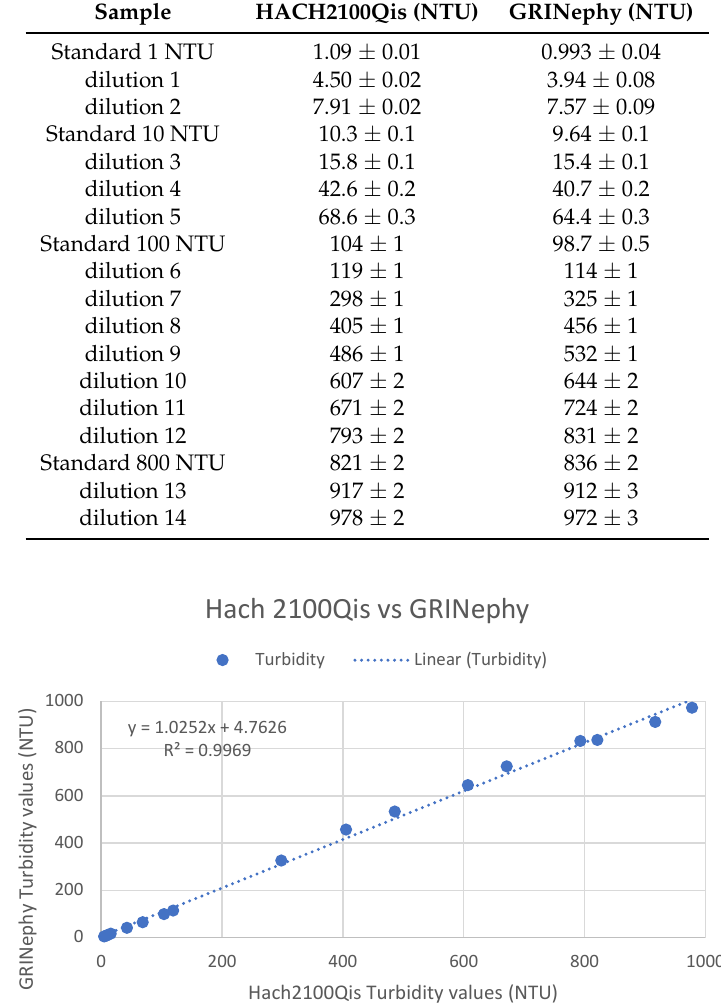
Figure 3. Validation of GRINephy: Values from the Hach2100Qis ( x -axis) and the GRINephy ( y -axis) using standard and diluted StablCal R (cid:13)